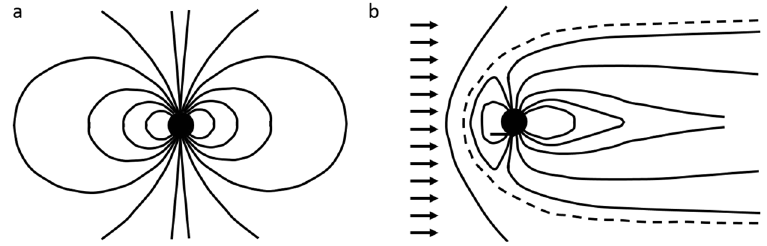
Figure 1. Magnetic field configuration of a magnetic dipole without ( a ) and with ( b ) a left-to-right flowing solar wind, illustrated as arrows, compressing the magnetic field into a magnetopause configuration. The magnetic field is deformed by the flowing plasma until the magnetic pressure balances the plasma pressure. The magnetopause is shown as the dotted field line in ( b